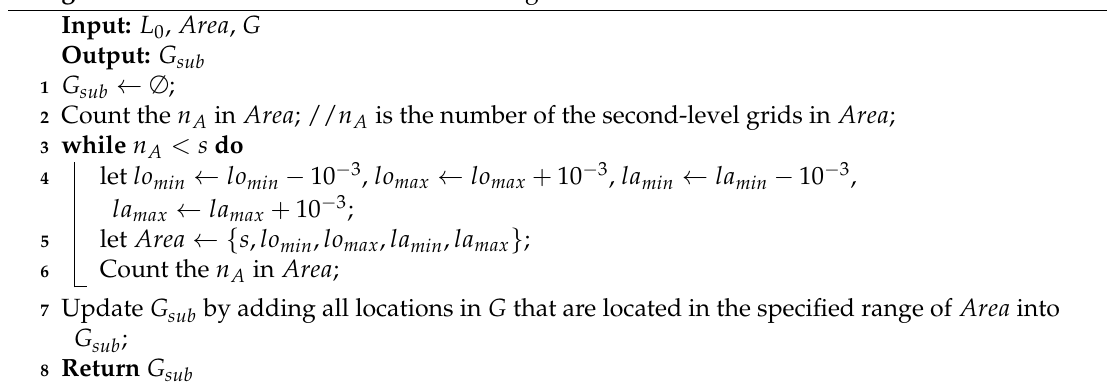
Algorithm 2: Historical location sub-dataset